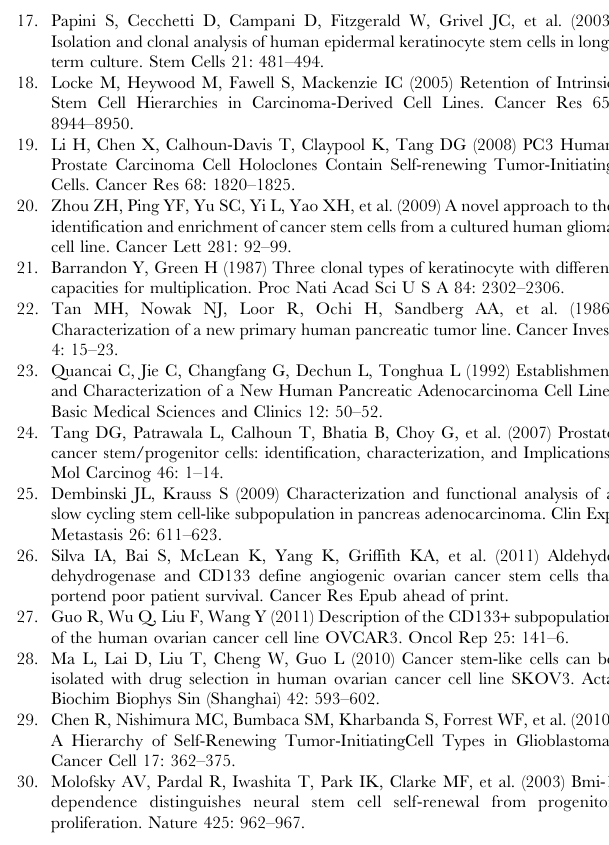
Figure S3 Long-term propagation capacity of distinct types of colonies derived from PC3 cell line. Holoclones (n =9, red line), meroclones (n =8, green line) and paraclones (n =8, blue line) were passage under common condition for 2 months. Life spans of each colony were recorded. 4 of 8 meroclones and 6 of 8 paraclones were aborted gradually, whereas 8 of 9 holoclones remained viable (p , 0.01). Figure S4 Histological characteristics of exnograft tumors derived from unsorted BxPC3 cell line and holoclones. 10 4 cells from unsorted cell line and holoclones were employed to produce xenograft tumors. H&E staining was performed to analyze the histological features of xenograft tumors derived from unsorted BxPC3 cell line (A) and holoclones (C) (Bar, 400 microns). The selected areas (black box) in panel A and C were magnified as panel B and D respectively (Bar, 100 microns). Figure S5 Expression of cancer stem cell markers CD44 and CD24 in holoclones and paraclones derived from pancreatic cancer cell line PC3. Cells in holoclones and paraclones derived from PC3 cell line were examined with flowcytometry for the cell surface markers of cancer stem cells. Flowcytometric plots (A) showed that CD44 (trunnion axis) was strongly positive and with little difference among distinct types of colonies. Three gates were set up to show the high (R1), medium (R2) and low (R3) level of CD24 (vertical axis) expression.